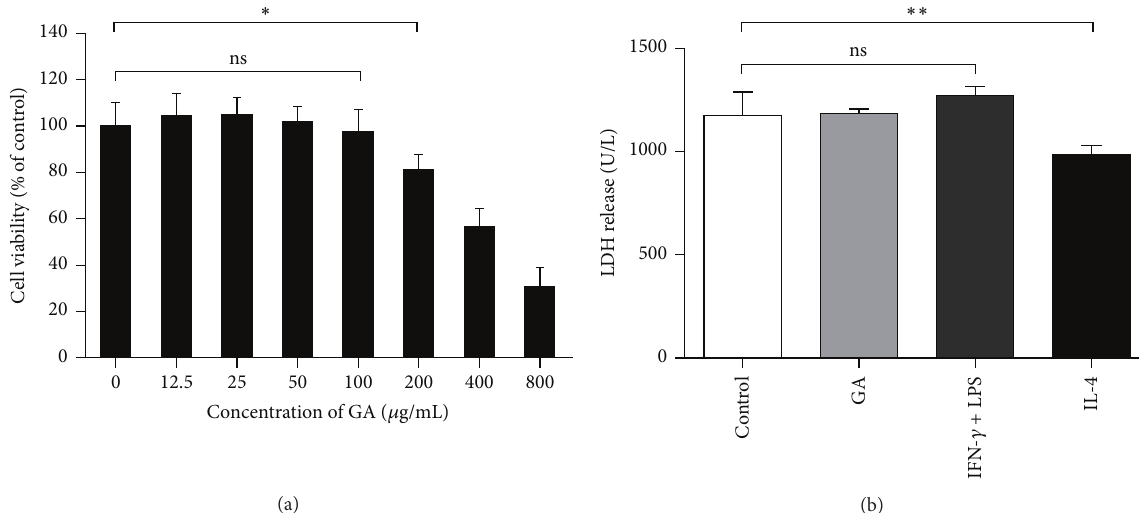
Figure 1: Determination of the noncytotoxic dose of GA. (a) BMDMs were incubated with GA at range from 0 to 800 𝜇 g/mL for 48h. Cell viability was determined by MTT method. The results are expressed as the percentage of viable cells and represent mean ± SD of eight samples. (b) Cell death was confirmed by measuring the release of the cytosolic marker LDH. BMDMs were treated with PBS, GA (100 𝜇 g/mL), IFN- 𝛾 (15ng/mL) + LPS (15ng/mL), and IL-4 (20ng/mL) for 48 h, and LDH activity in the supernatant was measured as described in Section 2. ∗ 𝑃 < 0.05 , ∗∗ 𝑃 < 0.01 ( 𝑡 -test).